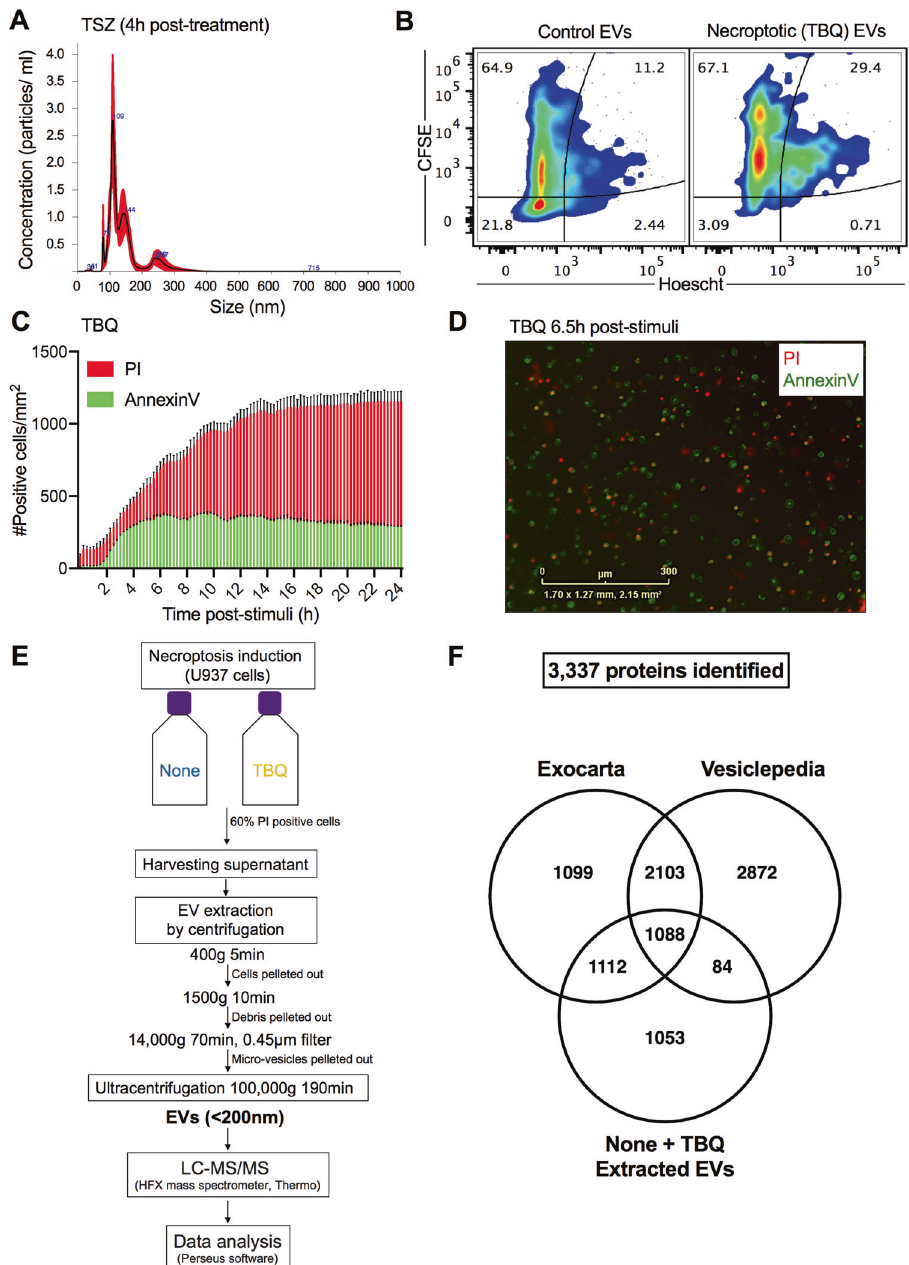
Fig. 1 Extraction of necroptotic extracellular vesicles (EVs). A U937 cells were treated with TNF- α (1.15 nM), SMAC (AZD5582, 2.5 mM), and z- VAD-fmk (20 mM) (denoted TSZ) to induce necroptosis. After 4 h, EVs were extracted using ultracentrifugation and analyzed for size and concentration by NanoSight. B CFSE-stained U937 cells were treated with TNF- α (1.15 nM), Birinapant (5 mM), and QVD-OPh (20 mM) (denoted TBQ) to induce necroptosis. Five hours later, EVs were extracted using ultracentrifugation, stained with Hoescht33342, and analyzed by fl ow cytometry (Attune NxT) for CFSE and Hoescht fl uorescence intensity to examine their protein and nucleic acid composition, respectively. C , D U937 cells were treated with TBQ as above to induce necroptosis. Cell viability was monitored using AnnexinV-FITC (green) and PI (red) via real-time imaging (IncucyteZoom). C Number of AnnexinV- and PI-positive cells per mm 2 at the indicated time points post stimuli. D Representative image of treated cells at 6.5 h post stimuli. E Schematic overview of the experimental and data analysis procedure. U937 cells were left untreated as a control (denoted none) or stimulated for necroptosis (TBQ). When TBQ-treated cells reached 60% PI positivity, supernatants were harvested for serial centrifugation and ultracentrifugation. Six pairs of independently extracted EVs were analyzed as biological replicates by mass spectrometry and Perseus data analysis software. F 3337 proteins were identi fi ed in the extracted EVs from both control (none) and necroptotic (TBQ-treated) cells by mass spectrometry. Venn diagram of total proteins identi fi ed in either none or TBQ- extracted EVs compared with the exosome proteome data bases, ExoCarta and Vesiclepedia. A , C , D Data are representative of at least three independent experiments. A Data are presented as the mean of fi ve acquired samples ±SEM and representative of three independent experiments. B Plots are representative of duplicate samples. C Data are presented as the mean of triplicate samples ±SD. EVs, extracellular vesicles; TSZ, TNF- α , SMAC, and z-VAD-fmk; TBQ, TNF- α , Birinapant, and QVD-OPh; PI, propidium iodide; h, hours; LC-MS/MS, liquid chromatography with tandem mass spectrometry; SEM, standard error of the mean; SD, standard deviation.